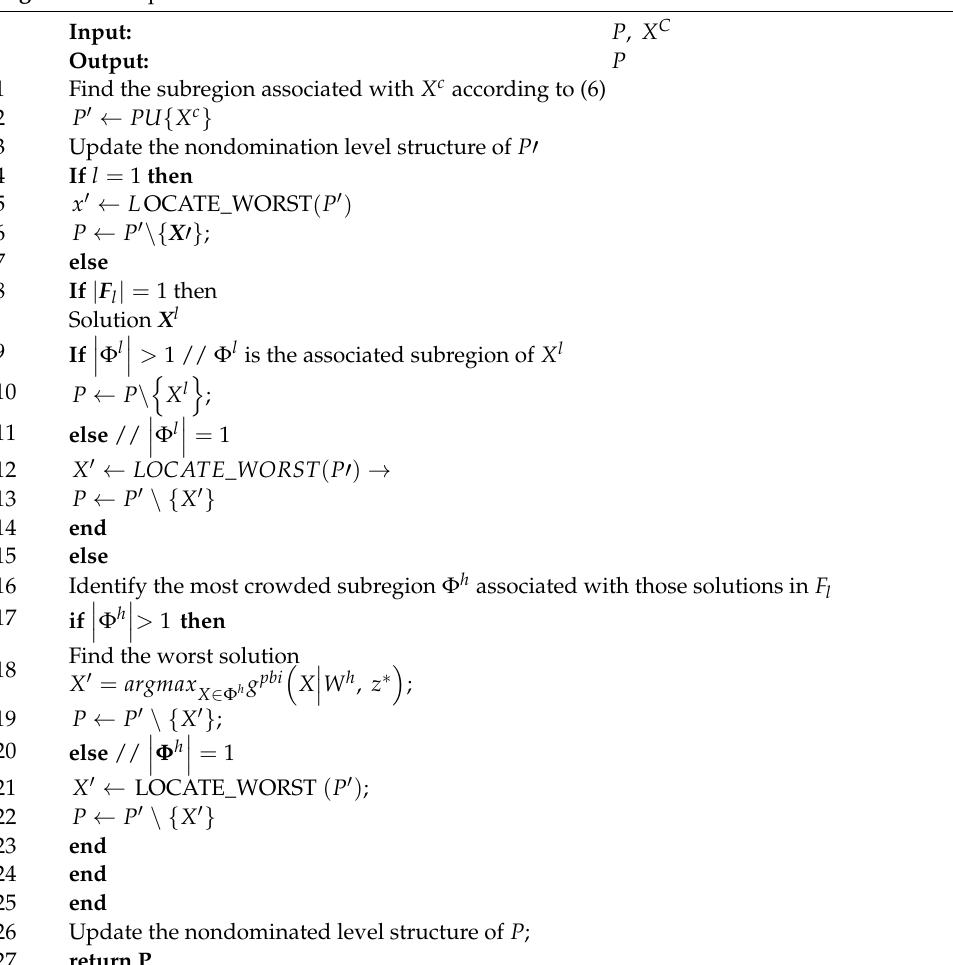
Algorithm 4. Update